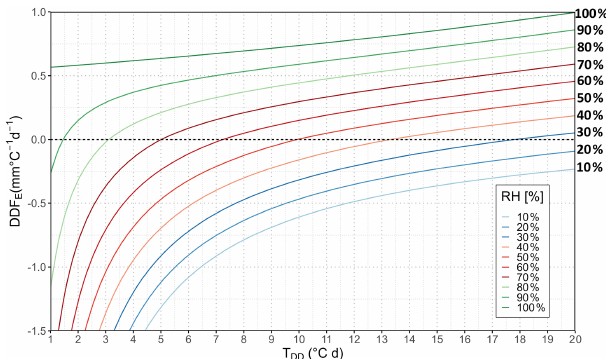
Figure 8. Latent heat component (DDF E ) for selected relative hu- midity (%), degree days ( ◦ Cd), and u = 1 (ms − 1 ), These values are for u = 1ms − 1 ; for a different wind speed these values can be mul- tiplied for the desired wind speed. Air density values are assumed at an elevation of 0ma.s.l.